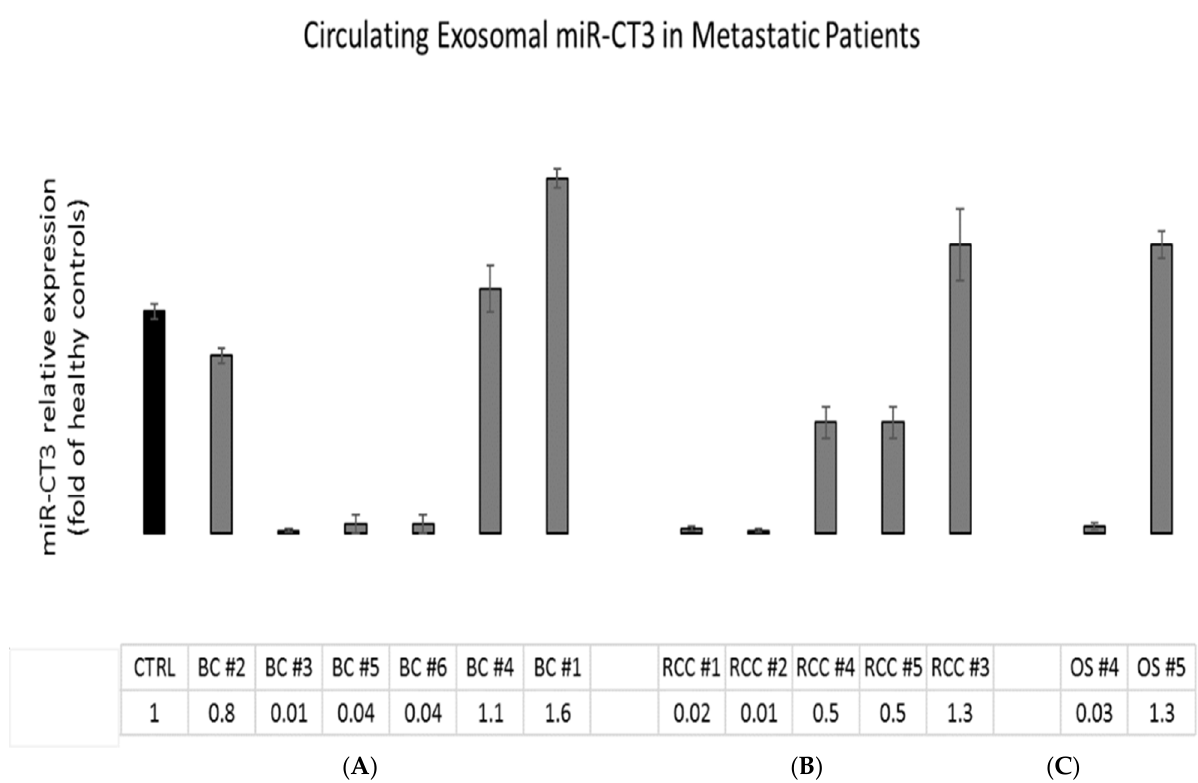
Figure 7. MiR-CT3 expression in metastatic cancer patient samples. ( A ) Barplots represent the circulating exosomal miR-CT3 expression in metastatic cancer patient samples ( B , C )-Breast Cancer; RCC-Renal Cell carcinoma and OS-Osteosarcoma). Values are expressed as fold of healthy controls (CTRL). Mean ± SD.